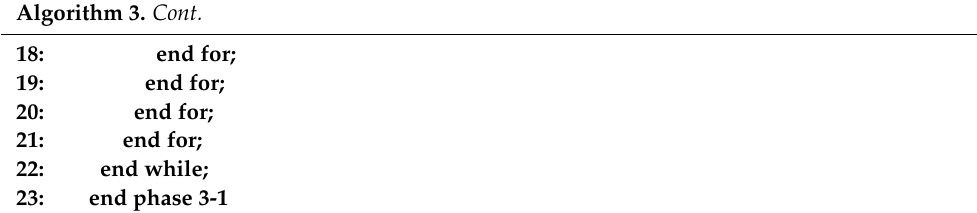
Algorithm 3. Cont.